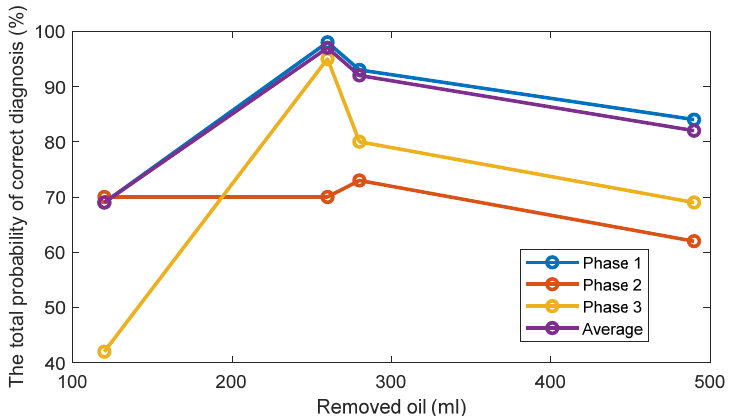
Figure 7. The TPOCD, provided by technology 1 (the third harmonic of the supply frequency) for three phases and 4 levels of oil removal compared to the standard oil level (Day 2).